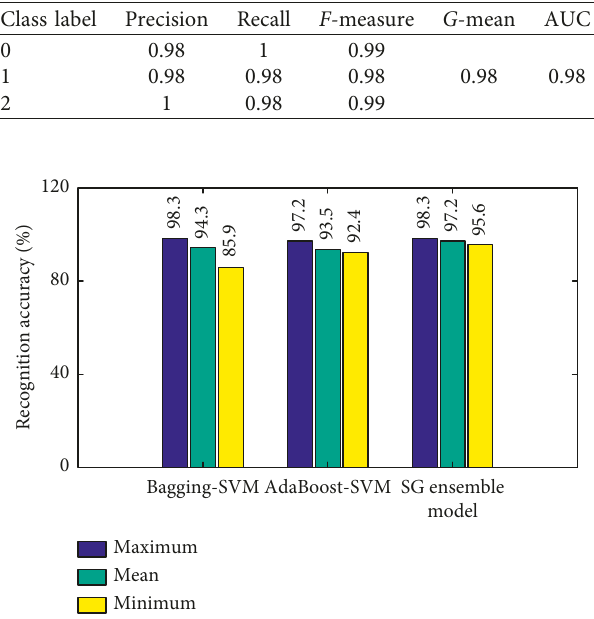
Figure 14: Comparison results of other ensemble models.